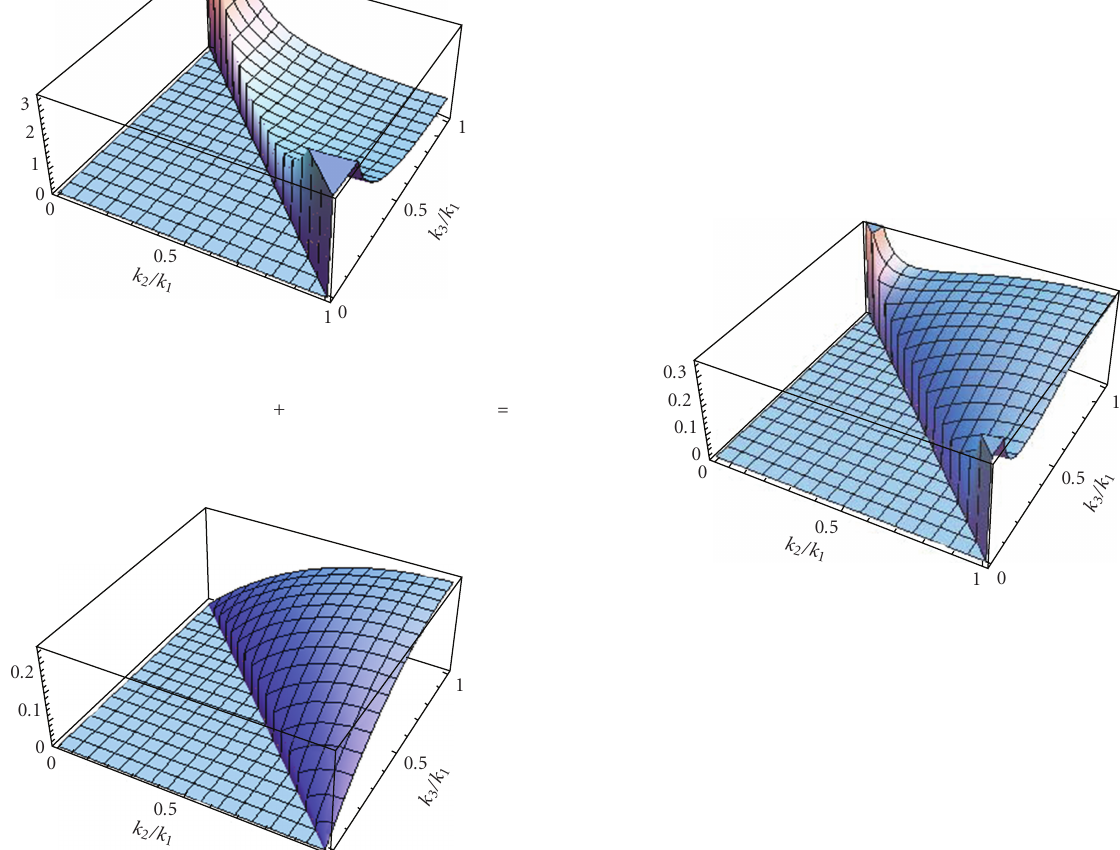
(cid:10) ; in the non- k 3